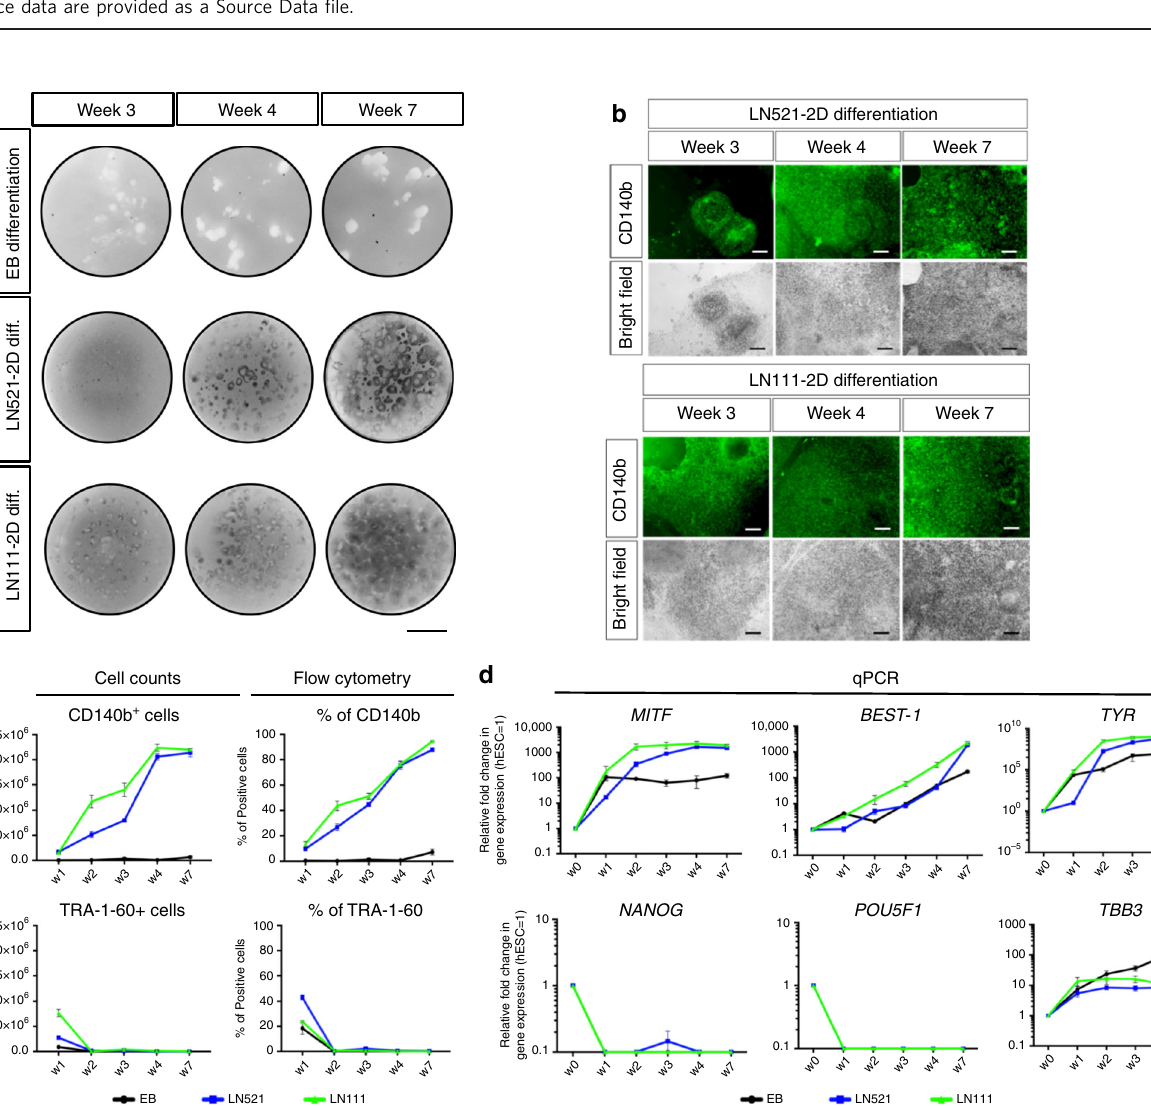
Fig. 1 hPSC-RPE cell surface marker screening and validation. a , b Schematics of the antibody library screen and dot-plot graphs displaying the most relevant markers identi fi ed with the antibody library and their relative degree of expression between the hESC and optic vesicle (OV) cell populations ( a ) and between the hESC and day 60 hPSC-RPE populations ( b ). Each dot represents a different cell surface protein, and their position along the x and y axes is determined by the percent positive value in hESC and optic vesicle-cell/hPSC-RPE samples. Based on their position in the chart, a subset of cell surface proteins have been categorized as hPSC speci fi c (bottom-right region) or optic vesicle speci fi c (top-left region). c Flow cytometry histograms representing percentage of positive cells for CD140b, GD2, and CD184 in the pigmented and non-pigmented fractions of the embryoid bodies after 30 days of differentiation. Representative bright fi eld pictures depicting the pigmented and non-pigmented fractions of the embryoid bodies that were analyzed by fl ow cytometry. Negative gates were set based on fl uorescence minus one (FMO) control samples. Results are based on pooled samples from three independent differentiations. d Immuno fl uorescence stainings displaying the expression pattern of CD140b, CD184, and GD2 cell surface markers in day 60 hPSC-RPE cells. e Upper: Bright fi eld and immuno fl uorescent pictures displaying the expression pattern of CD140b and human-speci fi c BEST-1 (does not label rabbit BEST-1) in albino rabbit subretinally injected with hPSC-RPE cells. Pigmentation is of human origin as albino rabbits lack pigmentation. Lower: Bright fi eld immunohistochemistry pictures showing the expression of CD140b in a human subretinal tissue section. f Bright fi eld and immuno fl uorescent images showing pigmentation, as well as BEST-1 and CD140b co-expression patterns in the CD140b + and CD140b − populations sorted at day 30 of differentiation. g Bar graphs representing the quanti fi cation of cells that are pigmented, BEST-1 + , CD140b + , BEST-1 and CD140b + in the CD140b + and CD140b − sorted populations. Bars represent means ± SEM from four different images. Scale bars: c = 200 μ m; d = 20 μ m; e , f = 50 μ m. Source data are provided as a Source Data fi le.